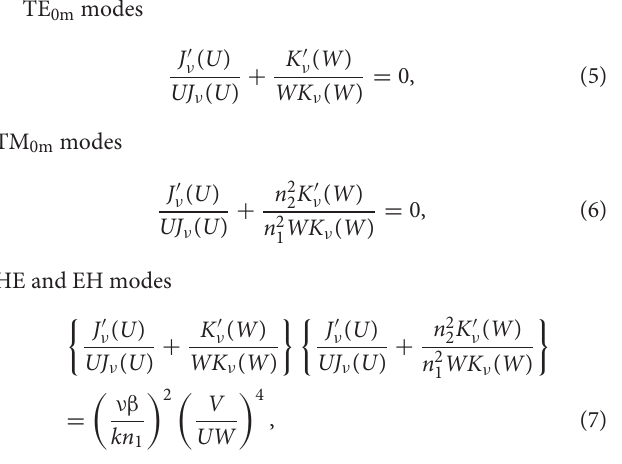
Frontiers in Chemistry |